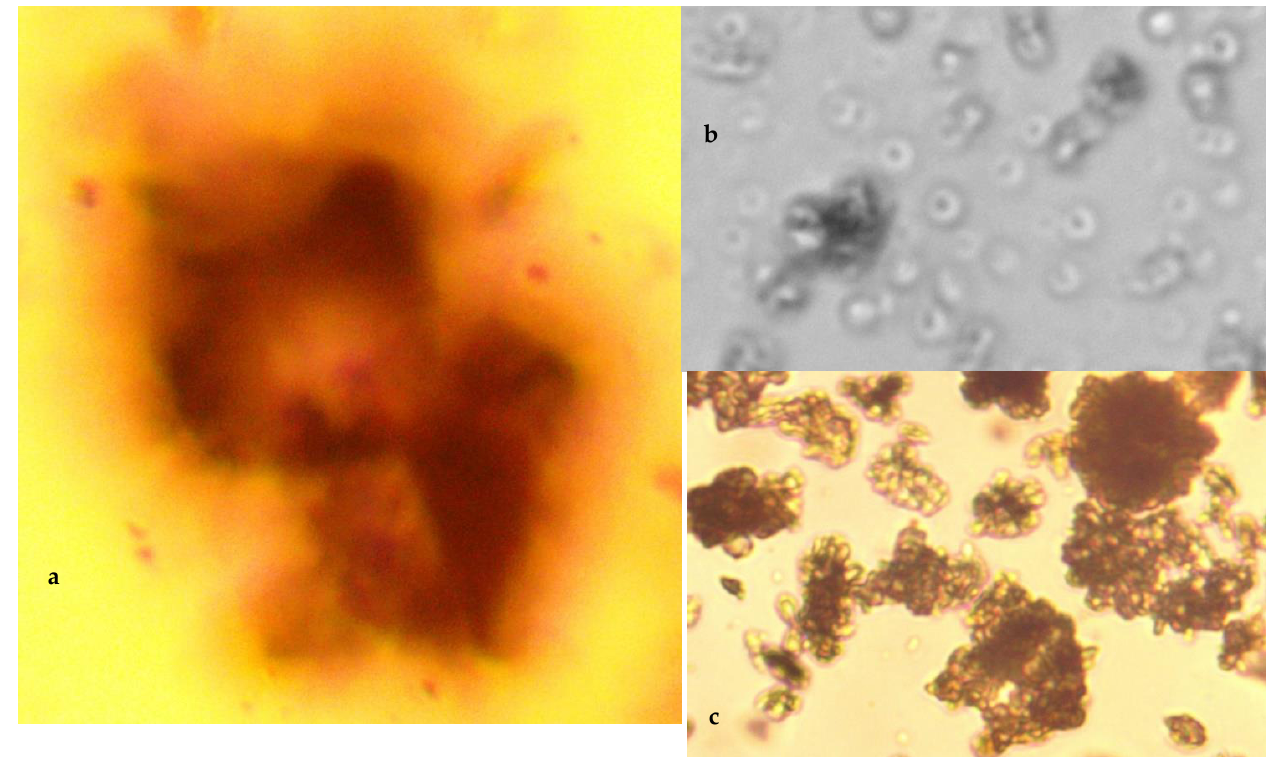
Figure 6. Colloidal nodules produced by n-Fe 0 . ( a ) fresh water. Agglomerated, hydrated, amorphous colloidal nodules produced by n-Fe 0 (50 nm diameter) in fresh water after 2 h. Transmitted light. Field of view = 0.057 mm. ( b ) Gas (hydrogen) and water filled, entrained, hydrated colloidal spheres produced by Fe 3 O 4 coated n-Fe 0 (50 nm diameter) in saline water after 2 h. Some of the spheres are starting to agglomerate. Transmitted light. Field of view = 0.04 mm. The relative refractive indices are: Hydrogen = 1.000132; water = 1.333; NaCl = 1.55; β -FeOOH = 2.365. The doughnut structures indicate the presence of a major refractive index contrast between a low refractive index core and a higher refractive index in the doughnut rim. ( c ), Agglomerated colloidal nodules produced by n-Fe 0 (50 nm diameter) in saline water (1.5 g L −1 ) after 4000 h. The cellular spheres are filled with minerals adsorbed from the water. Transmitted light. Field of view = 0.127 mm.